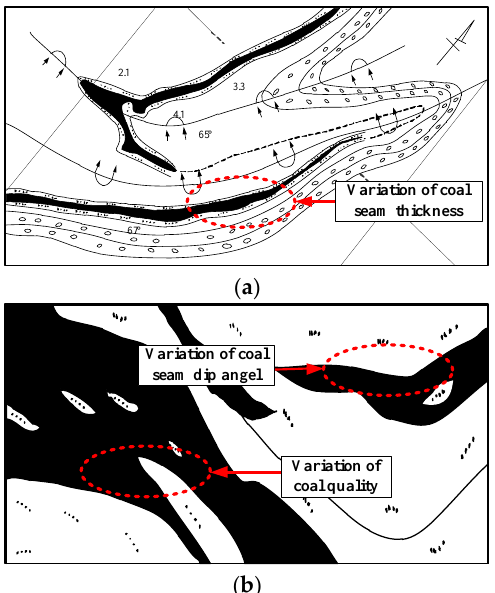
Figure 1. Tectonic areas with facies change. ( a ) Variation of coal seam thickness, ( b ) variations of coal seam dip angle and coal quality [13].